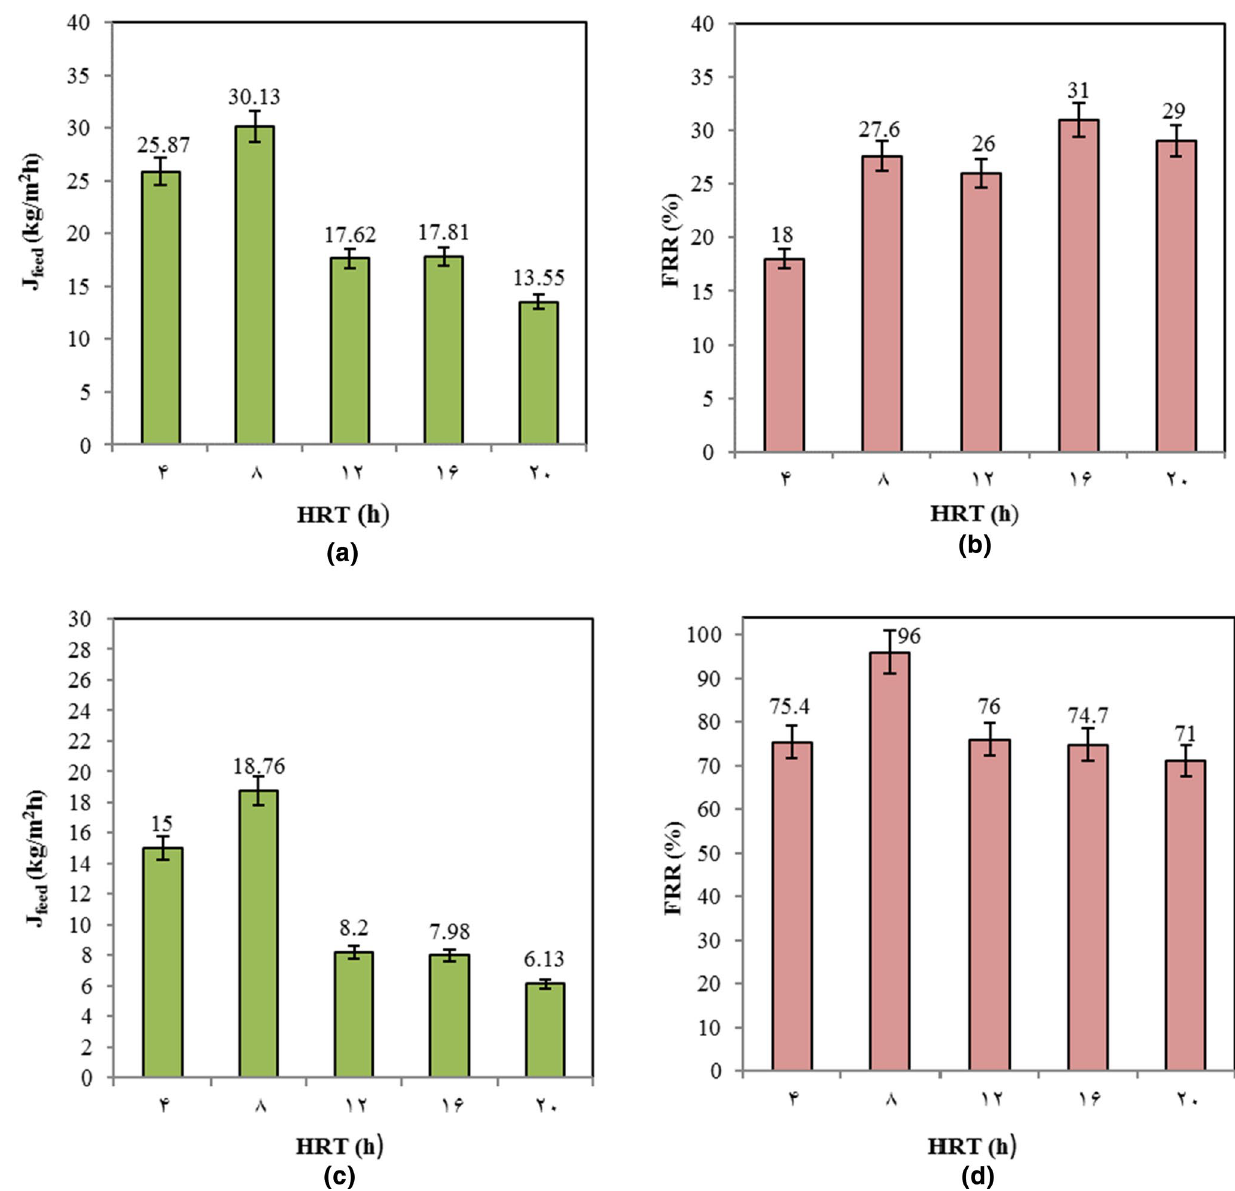
Fig. 3 J feed ( a ) and FRR ( b ) measured for MF membrane at constant pressure of 10 psi and constant pressure of 30 psi at different HRTs for pineapple fruit juice